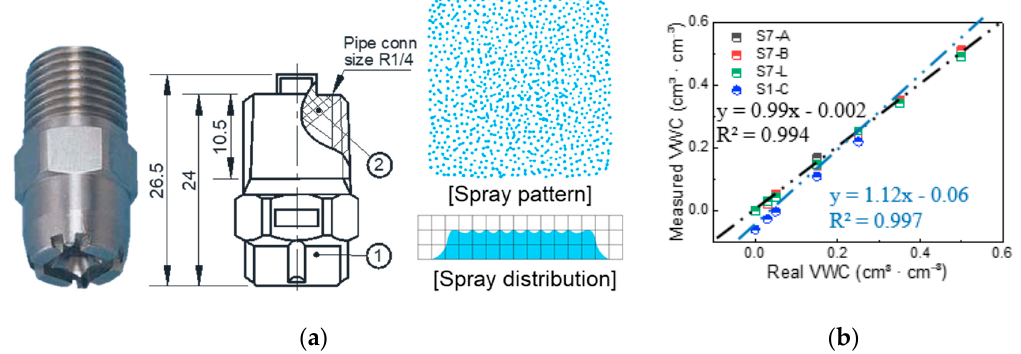
Figure 5. ( a ) Nozzle body and spray pattern and distribution for rainfall simulation; ( b ) calibration of